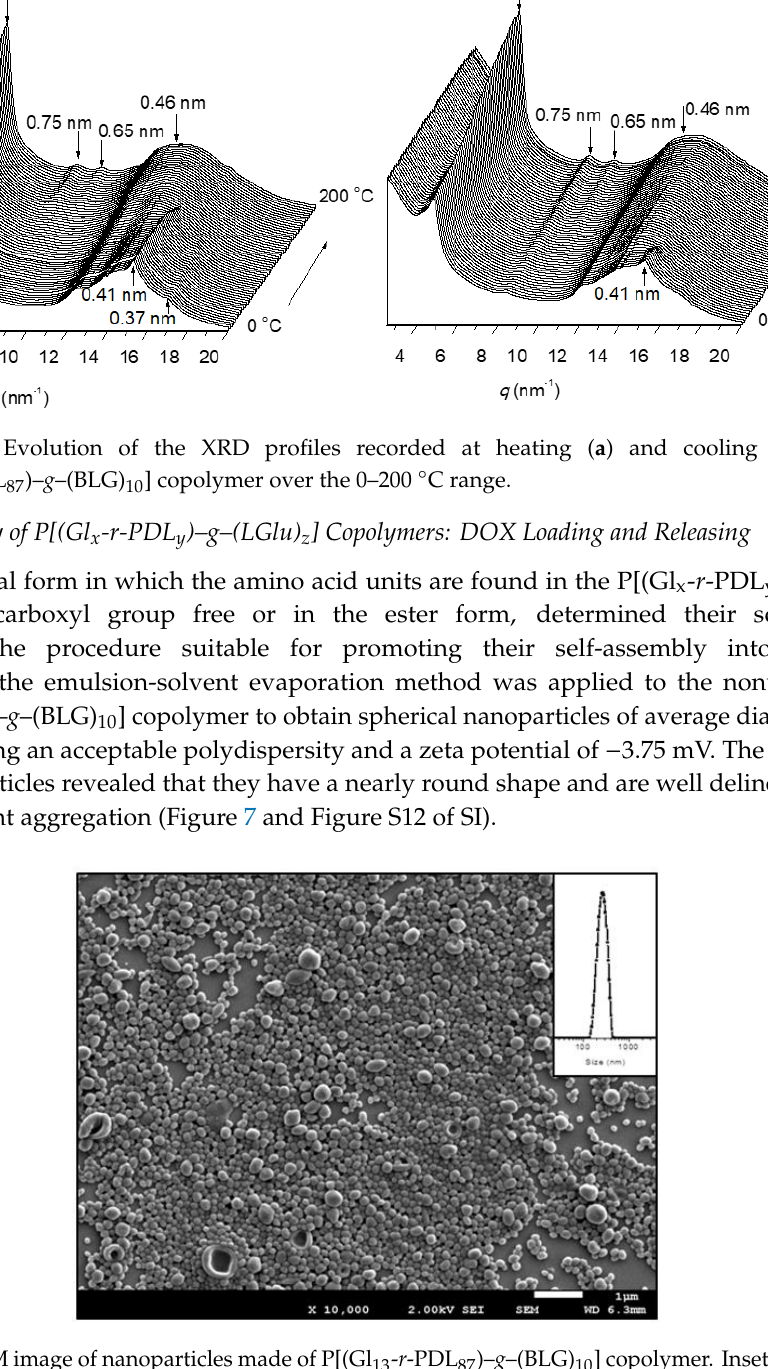
Figure 7. SEM image of nanoparticles made of P[(Gl 13 - r -PDL 87 )– g –(BLG) 10 ] copolymer. Inset: dynamic light scattering studies (DLS) profile recorded from the particle suspension. Additional SEM images are available in Figure S12 of SI.